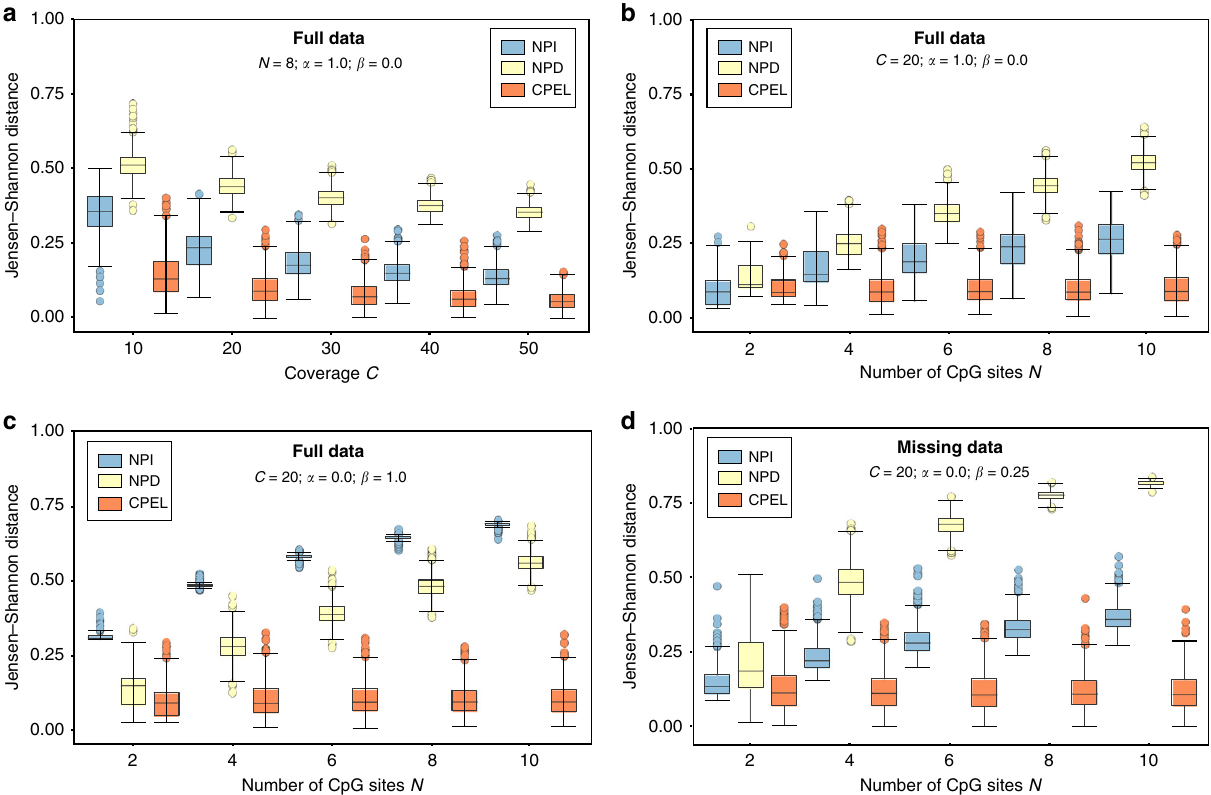
Fig. 3 Simulated evaluation of model estimation performance. Boxplots depicting distributions of Jensen – Shannon distance values when comparing estimated probability distributions of methylation (PDMs) to the true PDMs for a wide range of conditions using the NPI, NPD, and CPEL methods and simulated data. Estimation was independently performed 1000 times, each using fully observed or partially observed reads, as indicated. The results demonstrate a consistently superior performance of the CPEL method for correctly estimating methylation probabilities in a haplotype allele when compared to the NPI and NPD methods. a Fully observed non-correlated data and increased coverage. b Fully observed non-correlated data and increased number of CpG sites. c Fully observed correlated data and increased number of CpG sites. d Partially observed correlated data and increased number of CpG sites. Center line of box: median value; box bounds: 25th and 75th percentiles; lower whisker: larger of minimum value and 25th percentile minus 1.5 × interquartile range; upper whisker: smaller of maximum value and 75th percentile plus 1.5 × interquartile